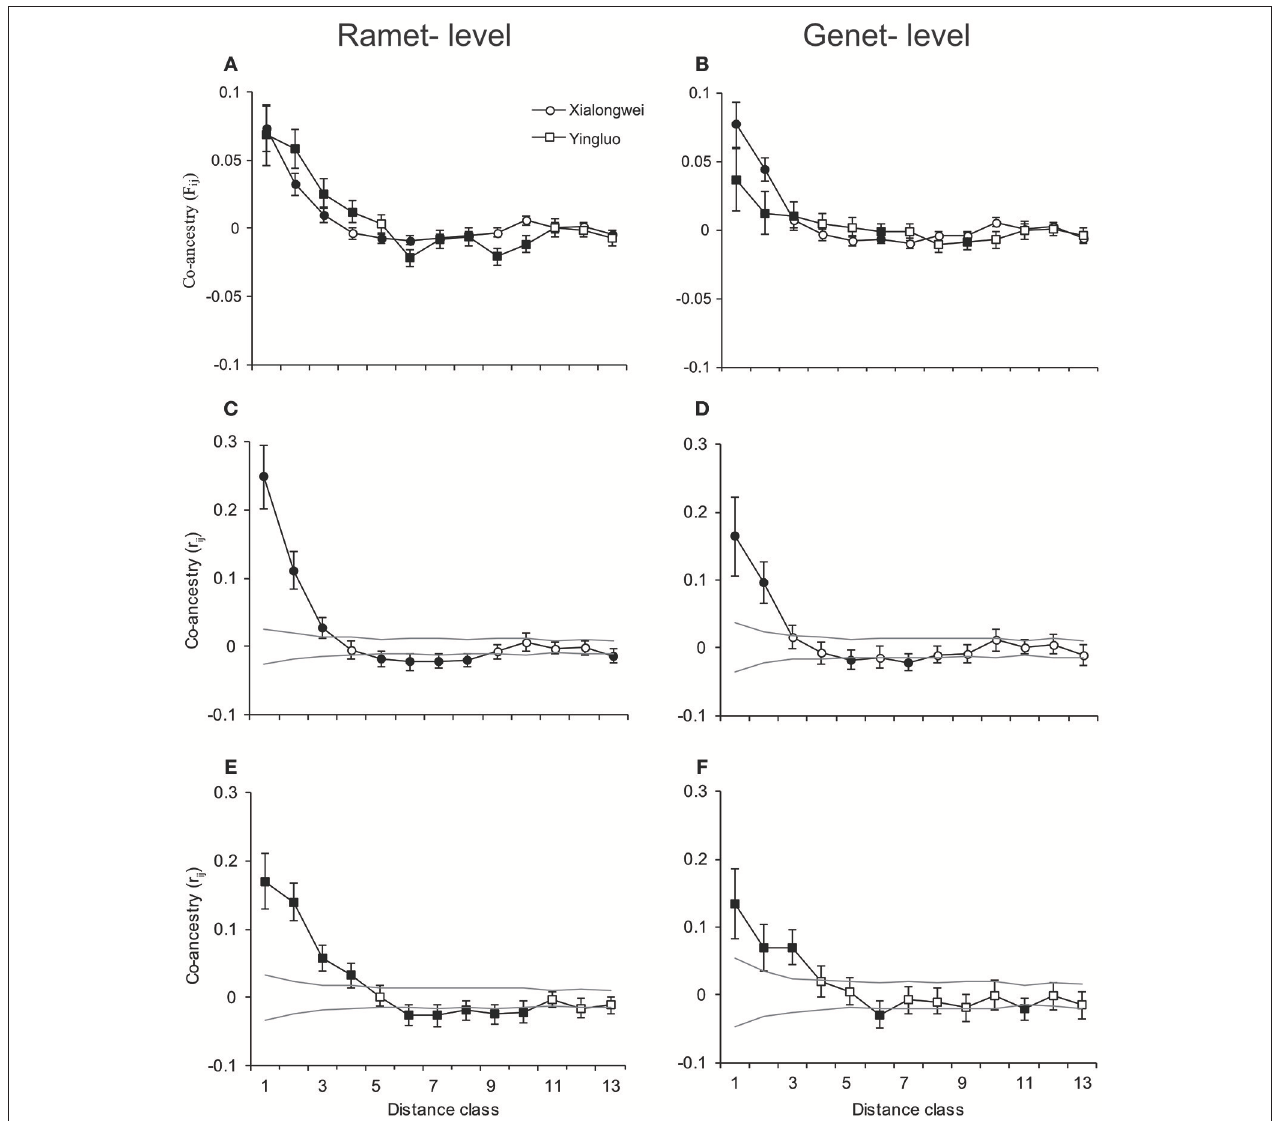
FIGURE 2 | Correlograms of (mean) pairwise co-ancestry parameter as a function of spatial distance for two Halophila ovalis populations. The first column of the correlograms was conducted at ramet level by including all sampling units, and the second column of the correlograms was produced at genet level by using central coordinates as spatial coordinates of genet. The first row correlograms showed co-ancestry ( F ij ) based on estimations from the software SPAGEDI v.1.3. The second and third row correlograms showed co-ancestry ( r ij ), based on GenAlex, of Xialongwei and Yingluo populations, respectively. The error bar for each index values in (A–F) is the standard error obtained from jackknifing over eight loci, and the dotted lines in (C–F) are 95% confidence interval of no association from 9,999 permutations. The values significant from zero were presented with filled circles and squares for Xialongwei and Yingluo, respectively.